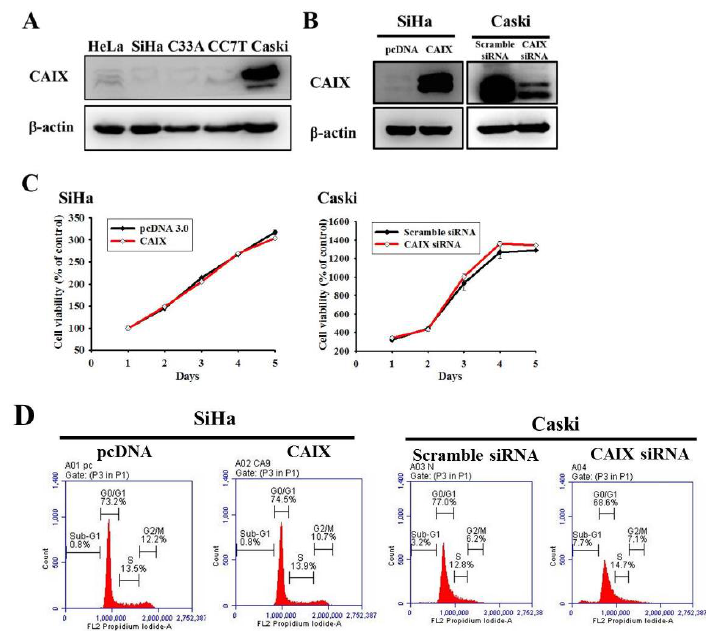
Figure 1. CAIX overexpression and knockdown in SiHa and Caski cell lines, respectively. ( A ) Endogenous CAIX protein levels were detected using Western blot analysis in human cervical cancer cell lines. ( B ) SiHa cells expressing low CAIX were transfected with a vector control (pcDNA 3.0) or CAIX-expressed vector (pcDNA-CAIX) for generating stably transfected clones (SiHa/pcDNA and SiHa/CAIX) after G418 selection. Caski cells expressing high CAIX were transiently transfected with scramble siRNA or CAIX siRNA. CAIX protein levels were detected through Western